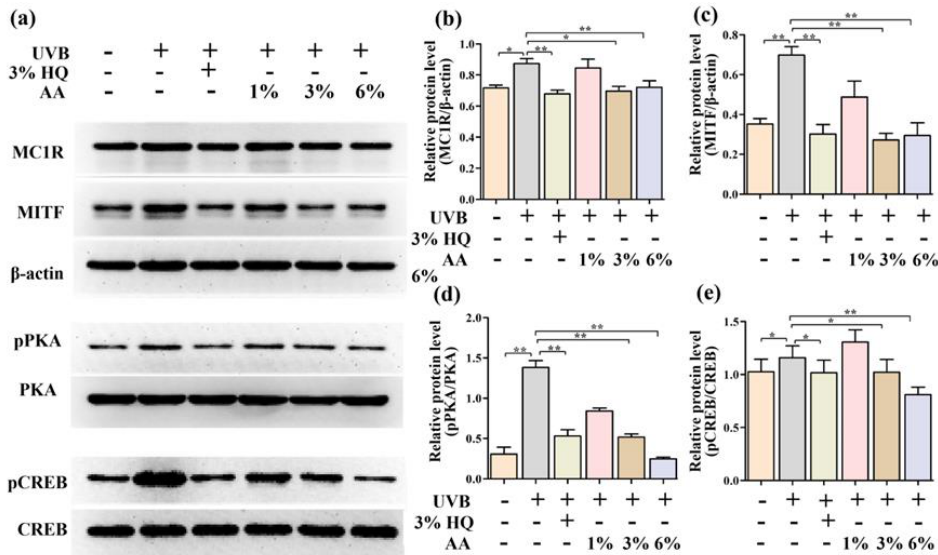
Figure 6. Effects of AA on the expression of MC1R, MITF, pPKA and pCREB of dorsal skin ( a ). The levels of MC1R ( b ), MITF ( c ), pPKA ( d ) and pCREB ( e ) proteins were quantified by densitometry. Data are expressed as mean ± SEM. * p < 0.05, ** p < 0.01 ( n = 6 per group). Then, using RT-PCR, we investigated the effects of AA on the relative quantification of the mRNA transcriptions of the MITF and tyrosinase genes. According to Figure 7, the mRNA levels of the MITF protein and tyrosinase protein were decreased by the AA. Taken together, the AA suppression of melanogenesis may be via inhibiting the PKA/CREB/MITF pathway and decreasing the expression of the MITF and tyrosinase genes.